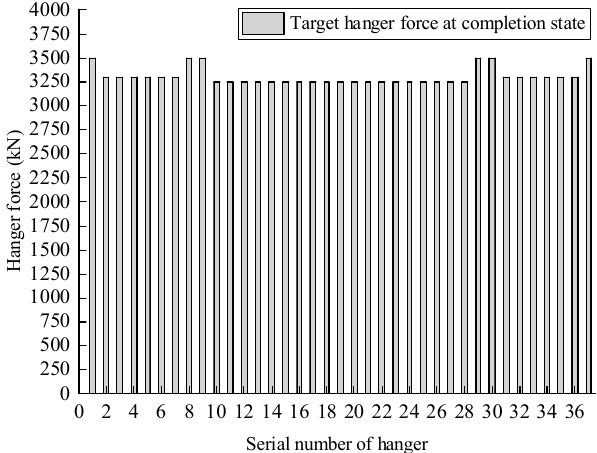
Figure 12. Target hanger force at the completion state (Unit: kN).